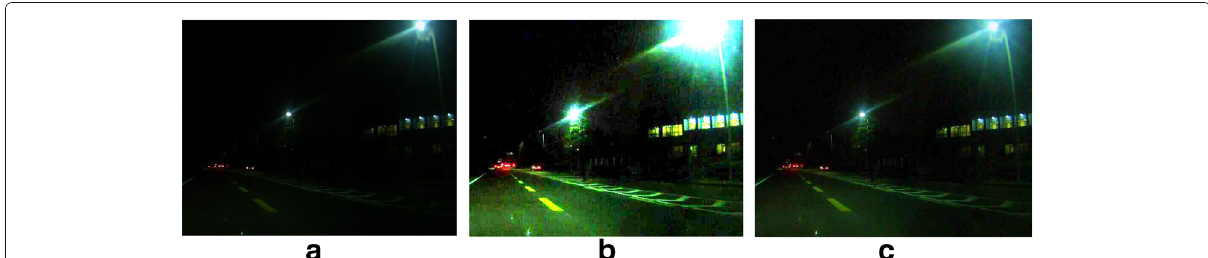
Fig.5 Illustrationofresultselectingthe“brightestpixel”astheatmosphericlight. a Inputimage. b Thebrightchannel. c Thefinalenhancementimage